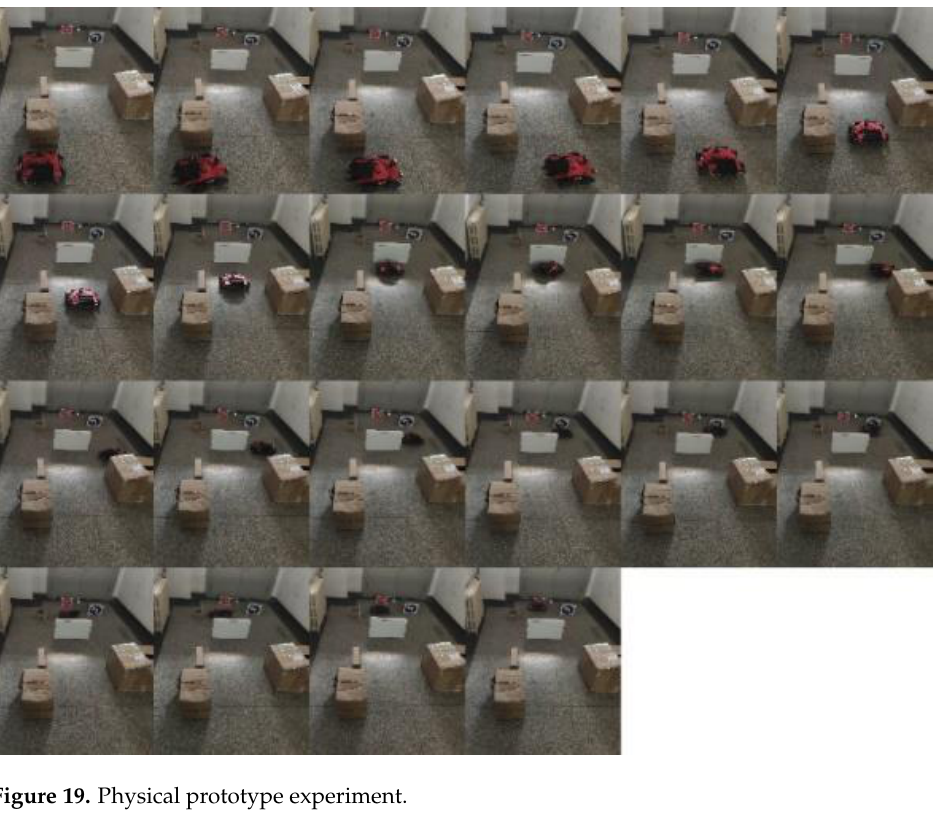
Figure 19. Physical prototype experiment.